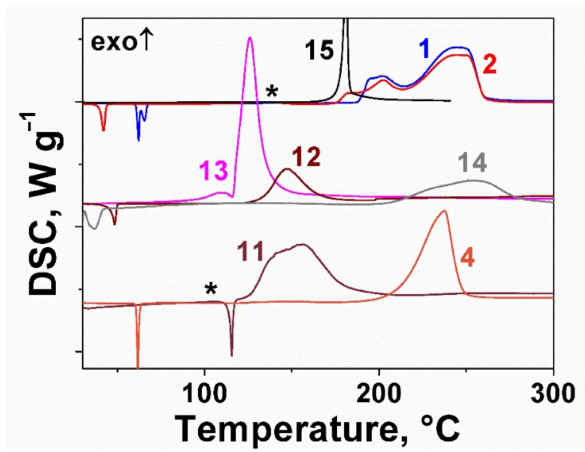
Figure 5. Thermal stability of monocyclic furoxans 1 , 2 , 4 , 11 – 15 . The di ff erential scanning calorimetry (DSC) curves were recorded at a heating rate of 5 K min − 1 . The stars indicate a weak heat release due to the thermal isomerization of 2 and 4 .